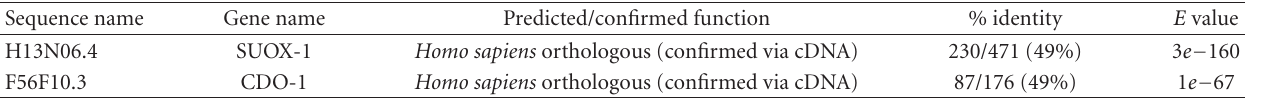
Table 3: Other C. elegans genes involved in SO 2